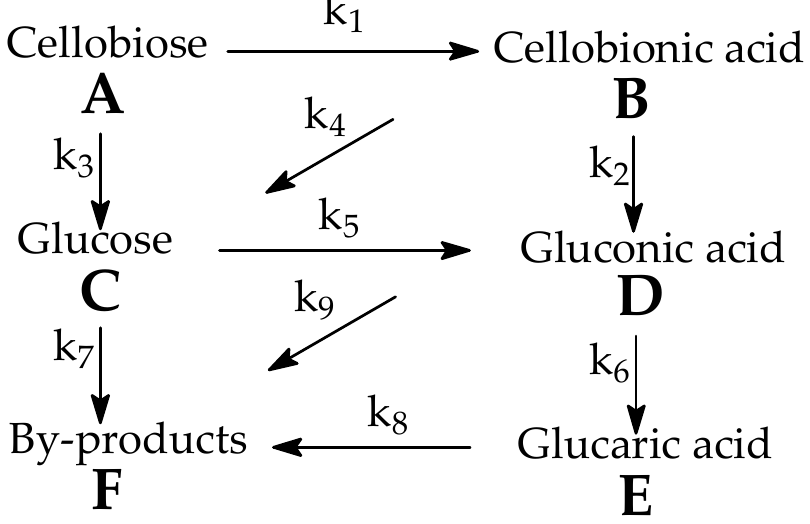
Figure 8. Scheme of the reaction of hydrolytic oxidation of cellobiose in the presence of the 3% Pt/HPS MN270 catalyst, obtained in the course of the mathematical modeling of the process. For kinetic modeling, we used the reduced time parameter θ = τ /q, where τ is the reaction time and q is the load on the catalyst (q = C 0 /C cat , where C 0 is the substrate concentration and C cat is the catalyst concentration). To generalize the experimental data obtained at different values of the load on the catalyst (q), a transition was made to the numerical concentration of cellobiose and its hydrolytic oxidation products in accordance with the formula X i = C i /C 0 , where Ci is the current concentration of the product, mol/L, and C 0 is the current concentration of cellobiose, mol/L. The experimental data were reduced to coordinates X~ θ . Thus, the mathematic modeling of the experimental data can be presented as a system of differential